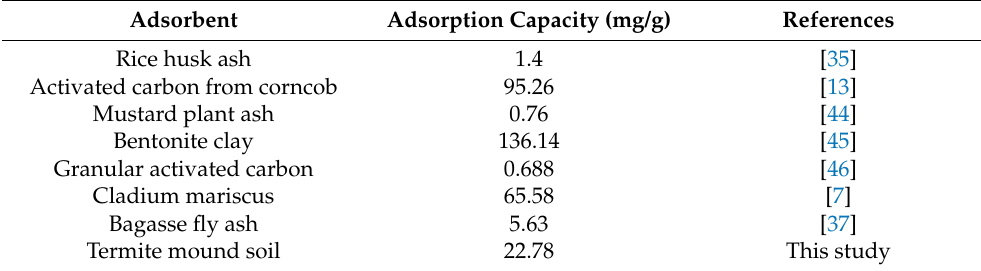
Table 5. Comparison of 2,4-D Langmuir adsorption capacities of different adsorbents.